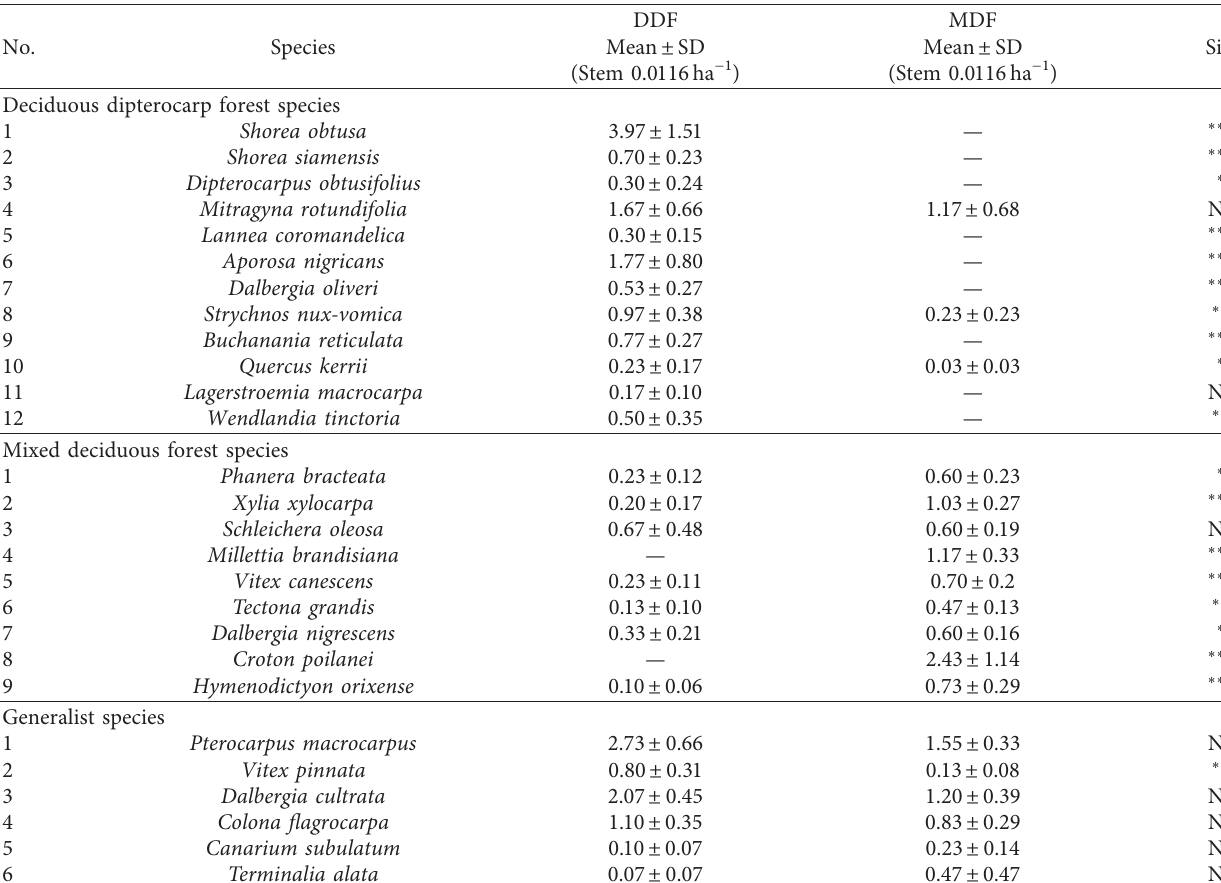
Table 3: Mean ± standard deviation of the total stem density of seedlings (in 4 × 4 m subplots) and saplings (in 10 × 10m quadrats), sampled from locations at the same position along each belt plot inside the deciduous dipterocarp forest (DDF) and mixed deciduous forest (MDF). No.